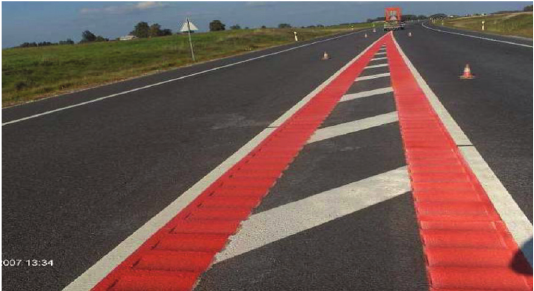
Fig. 3. Rumble strips in the intersection